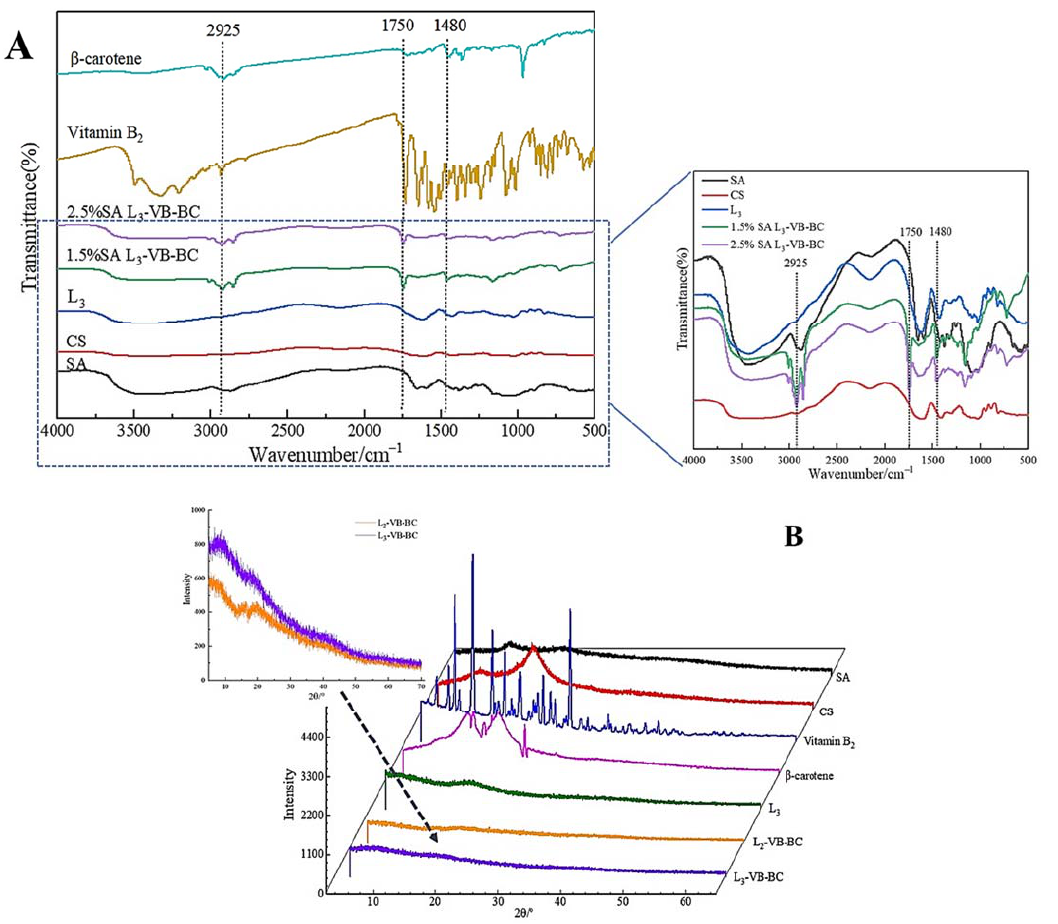
Figure 1. FT-IR and XRD of SA, CS, vitamin B 2 (VB), β -carotene (BC) and gel microspheres. ( A ) FT- IR analysis of SA, CS, the three-layer-gel microspheres (L 3 ), 1.5% SA VB and BC-loaded gel microspheres (1.5% SA L 3 -VB-BC), 2.5% SA VB and BC-loaded gel microspheres (2.5% SA L 3 -VB- BC), VB, and BC; ( B ) X-ray diffraction images of SA, CS, VB, BC, the three-layer-gel microspheres (L 3 ), two-layer VB and BC-loaded gel microspheres (L 2 -VB-BC), and three-layer VB and BC-loaded gel microspheres (L 3 -VB-BC).